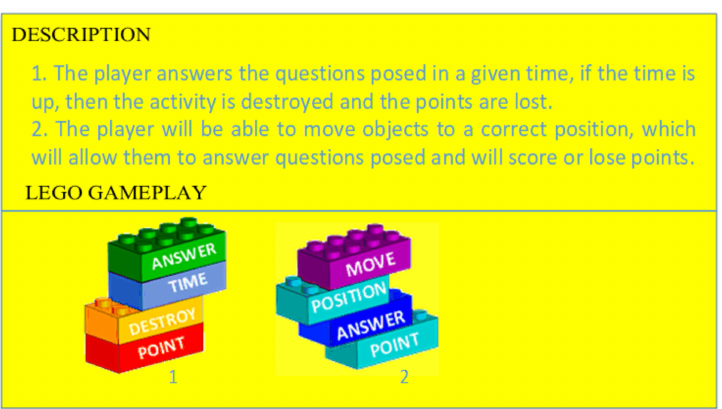
Figure 14. Consensual Game Script.